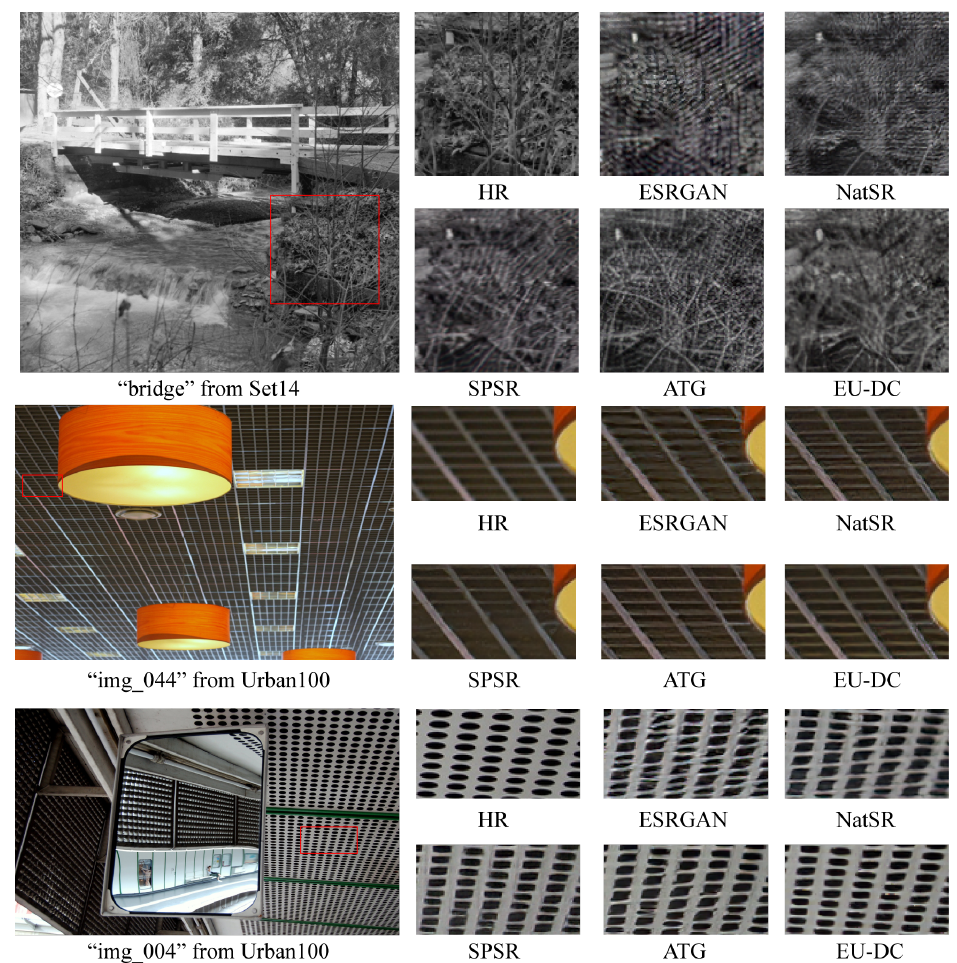
Figure 4. Visual results of different GAN-driven methods. Our proposed method reduced the distortion in the image and produced more natural textures and clearer structures than the other SR methods